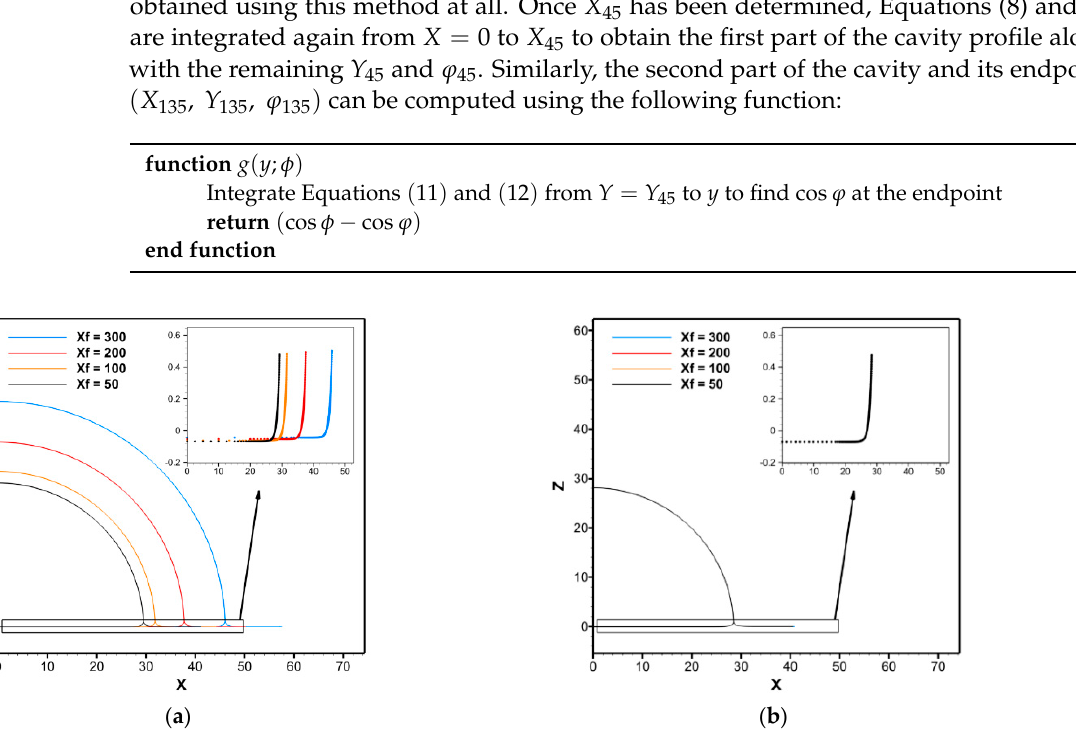
Figure 2. Comparison of the bubble shapes obtained according to the boundary point X f of Equa- tions (8) and (9) for a large bubble ( B = 10 − 16 ) using ( a ) the conventional method, and ( b ) the improved method involving the root-finding technique. The tolerance of the ODE solver is set to 10 − 9 . The insets plot the cavity profiles up to 45 degrees and are not